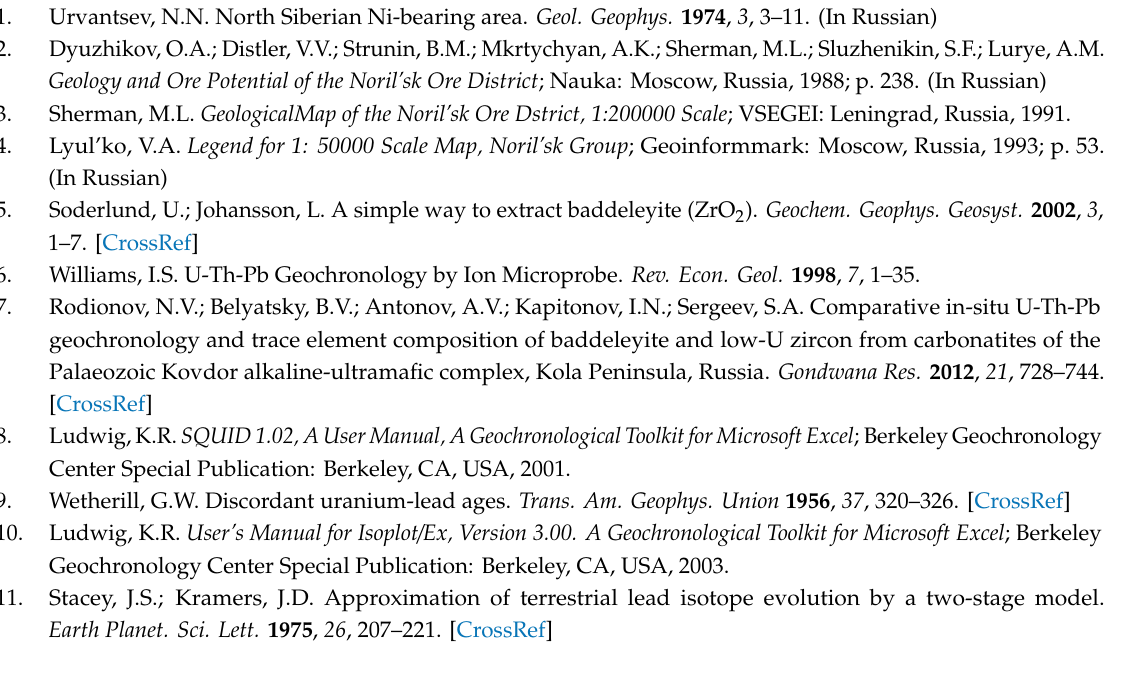
Table S1: Bulk compositions of igneous rocks within the Turumakit